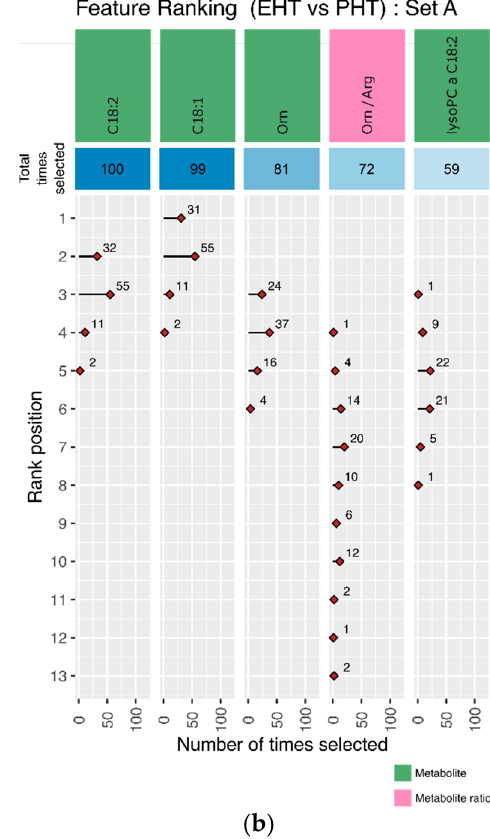
Figure 3. ( a ) Heatmap showing the number of times a feature (metabolites or its ratios) was selected for EHT vs PHT disease comparison in different sets (A–F). ( b ) Feature ranking for Set A in EHT vs PHT disease